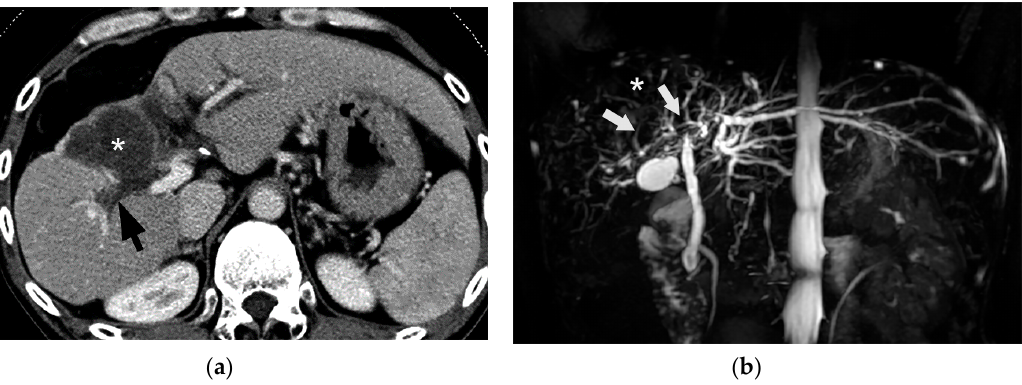
Figure 14. Comparison between CT and MR cholangiopancreatography (MRCP) findings of BDN. ( a ) On contrast-enhanced CT, a hypodense tubular structure is observed in the hilar area of the right liver lobe (arrow). Adjacent to this tubular structure, a large hypodense mass is observed in the medial segment of the liver (*). These structures are BDN (arrow) and a biloma (*). A dilated intrahepatic bile duct is also observed in the lateral segment of the liver (arrowheads). ( b ) On MRCP, although dilated intrahepatic bile ducts in the left lateral lobe of the liver are clearly observed, bile ducts in the hilar region and right hepatic lobe are unclear (arrow). Furthermore, the biloma in the medial segment of the liver is not clearly depicted on MRCP (*).